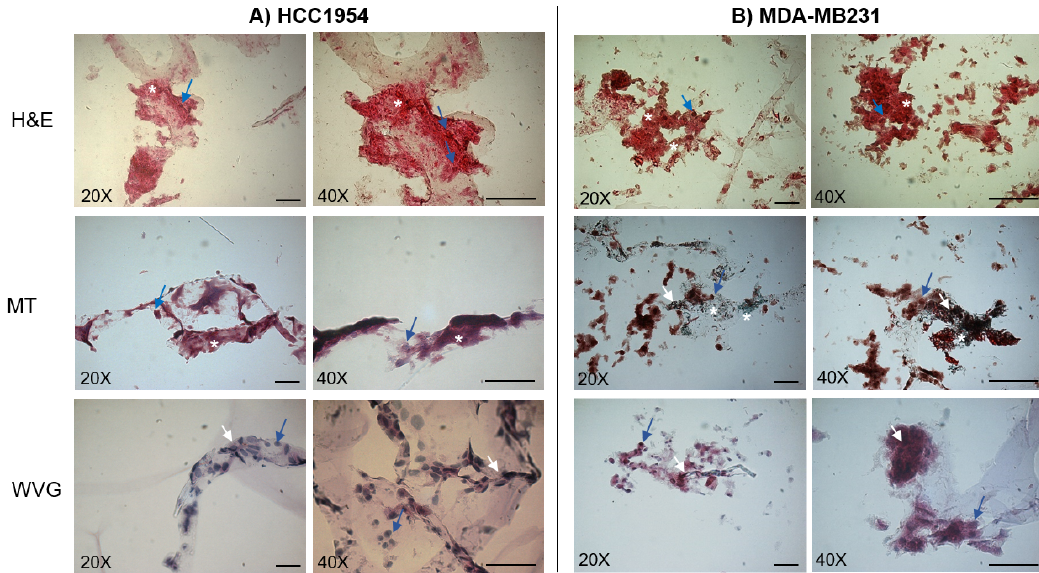
Figure 2. Histological images of HCC1954 ( A ) and MDA-MB231 ( B ) cells cultured in the 3D scaffold for seven days. Representative images acquired by an inverted microscope after staining with Hematoxylin and Eosin (H&E), Masson Trichrome (MT), and Wiegert Van Gieson (WVG) methods. The blue arrows indicate cells, the white stars the extracellular matrix, and the white arrows indicate collagen. Data are from triplicate wells for each condition in two independent experiments. Scale bar 100 µm. Magnification 20× and 40×.